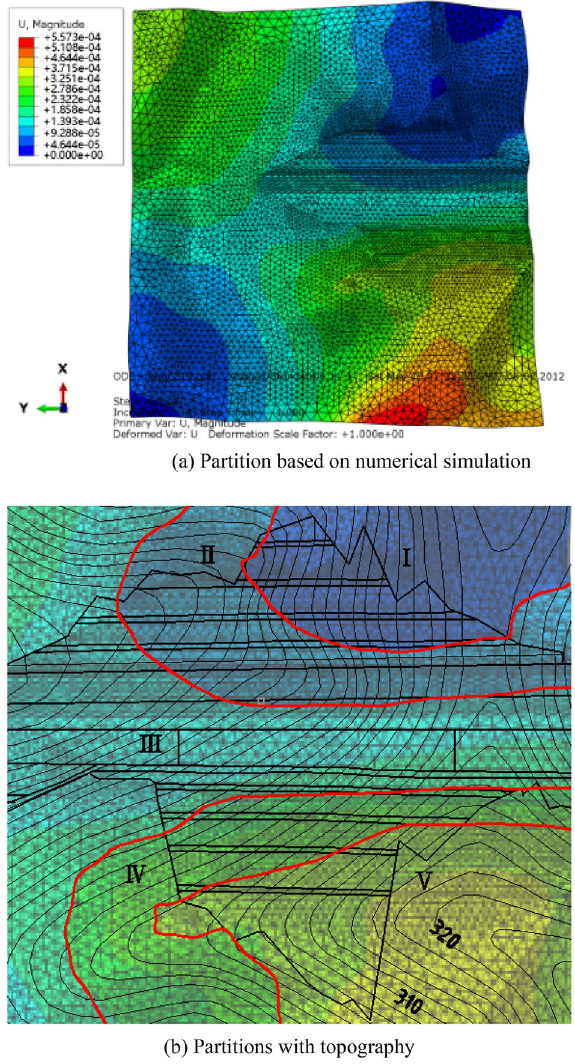
Figure 22. Monitoring partition based on